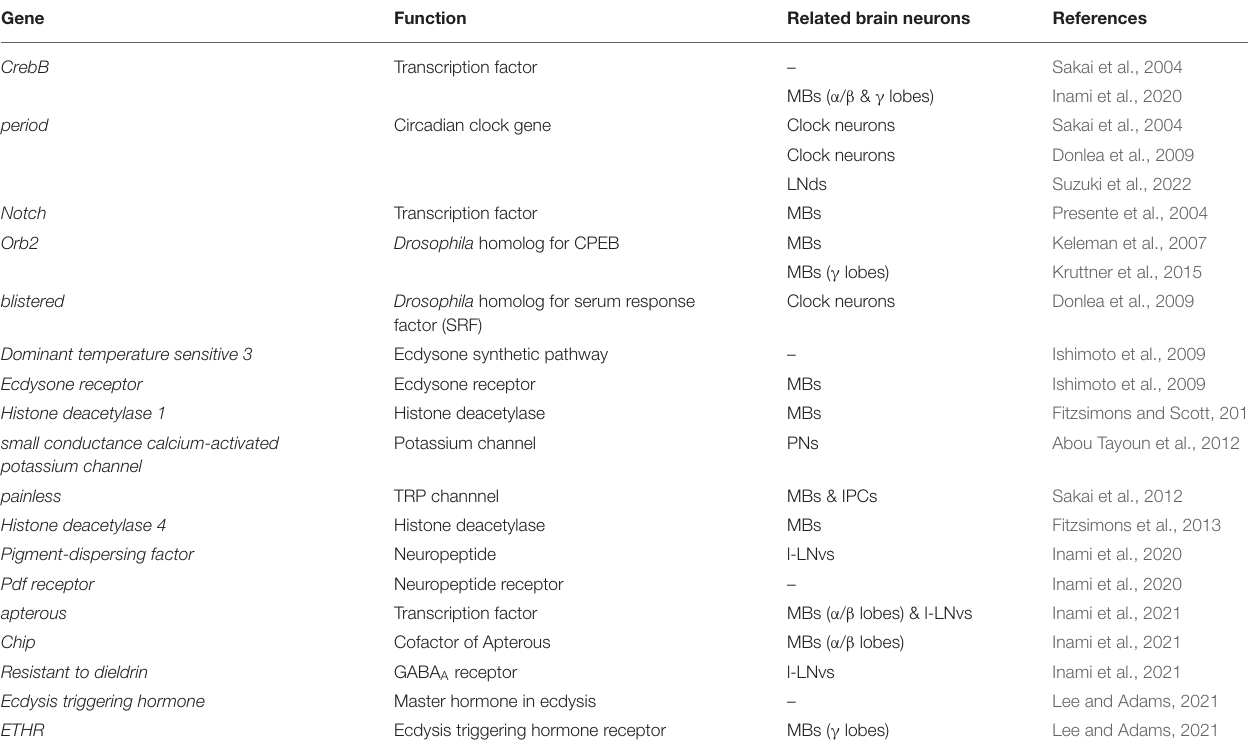
TABLE 1 | Genes related to courtship LTM in Drosophila